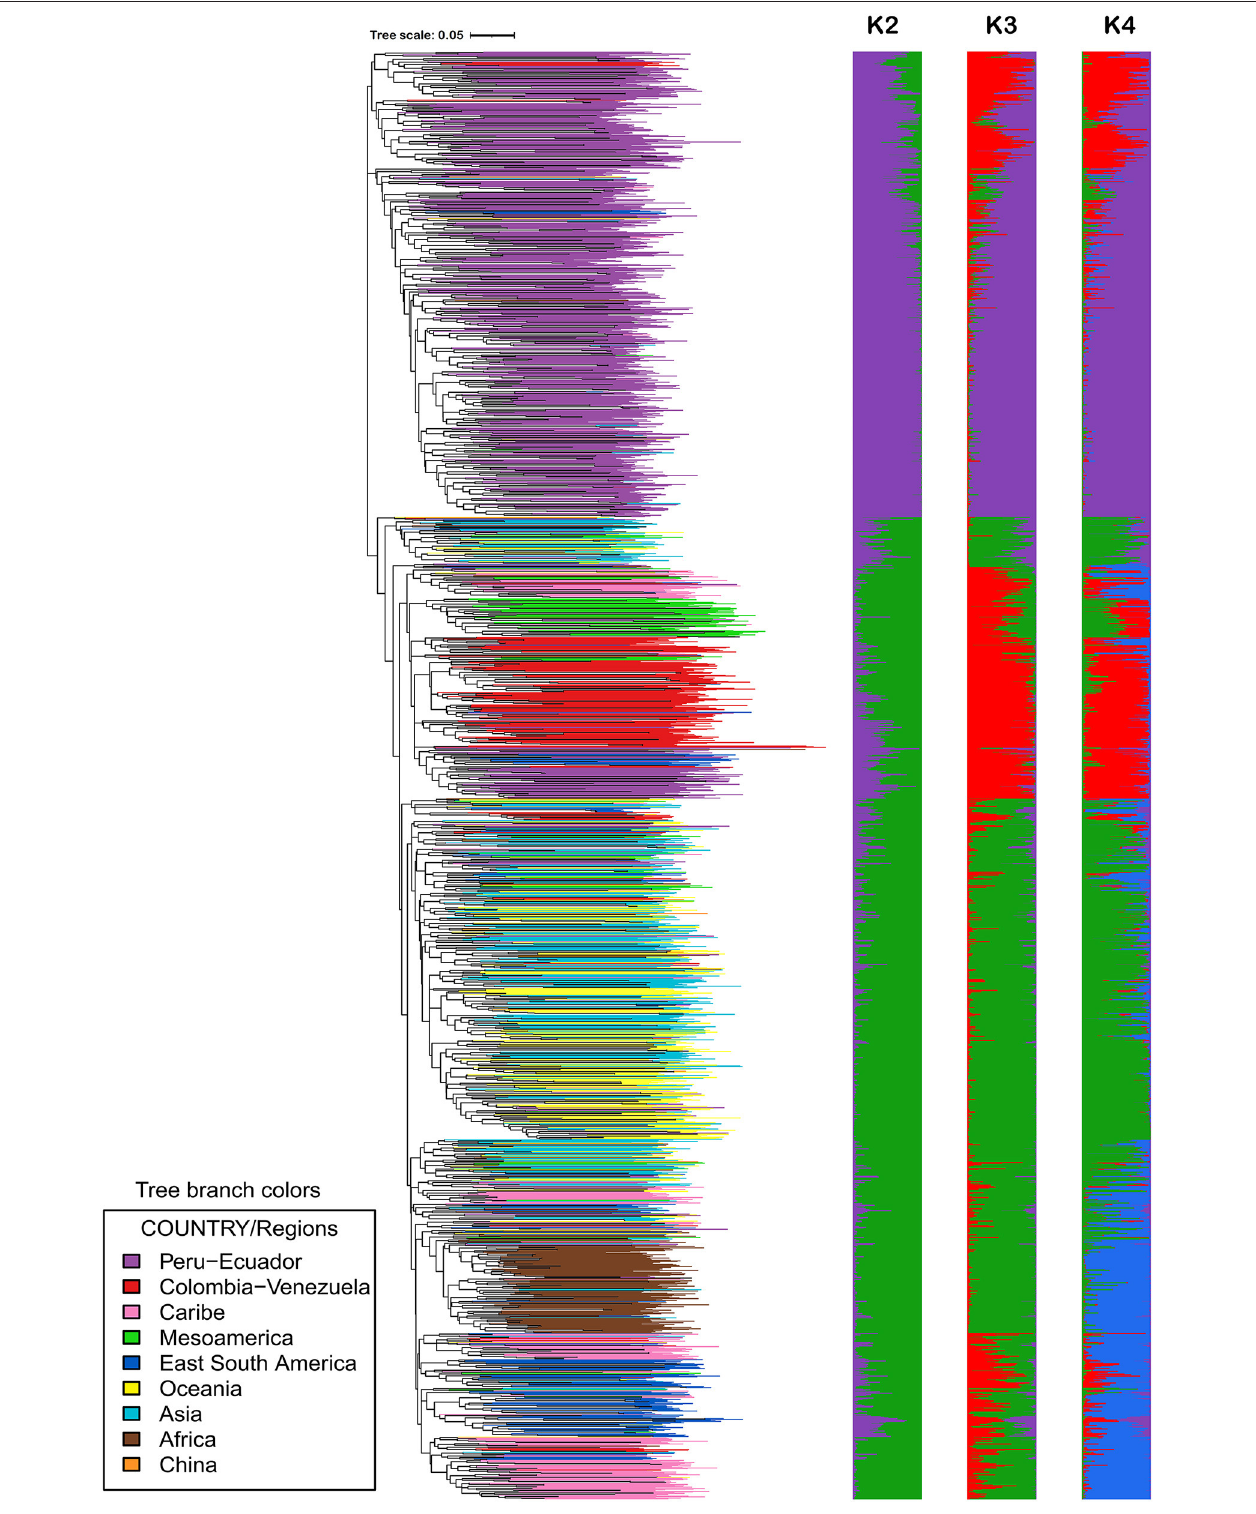
FIGURE 3 | Analysis of population structure and phylogenetic relationships of 2,109 landraces in the germplasm collection at CIP. K = 2 to K = 4 is displayed here. The phylogeny was created from calculating a pairwise genetic similarity distance matrix and subsequently employing neighbor-joining to construct the intraspecific relationships. iTOL was employed to color code branches by country of origin or donations.